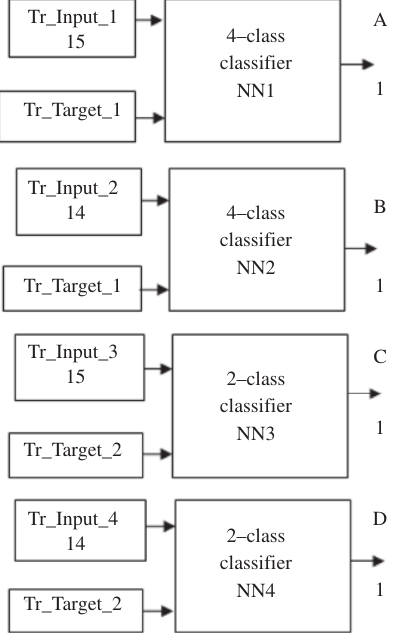
Figure 9: Neural Networks Training Inputs, Outputs, and Targets.